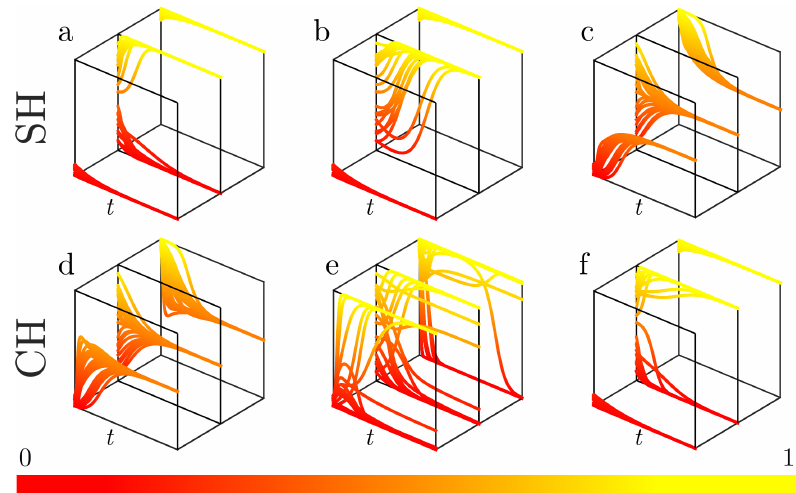
Figure 4. Simulations of the SR-EGN Equation (8) for the SH game ( T = 0.5 and S = − 0.5) and CH game ( T = 1.5 and S = 0.5). In subplots ( a , d ), β v = − 2 k v < − k v ∀ v ∈ V , in ( b , e ), β v = 0 ∀ v ∈ V , and in ( c , f ), β v = 2 k v > k v ∀ v ∈ V ( f ). In all subplots, the first slice refers to simulations with random initial conditions close to full defection, the middle one refers to simulations with random initial conditions in int ( ∆ N ) , while the last one refers to simulations with random initial conditions close to full cooperation. The numerical simulations have been performed using the build-in ODE solver ode45 explicit Runge–Kutta (4,5) of Matlab R2020b.